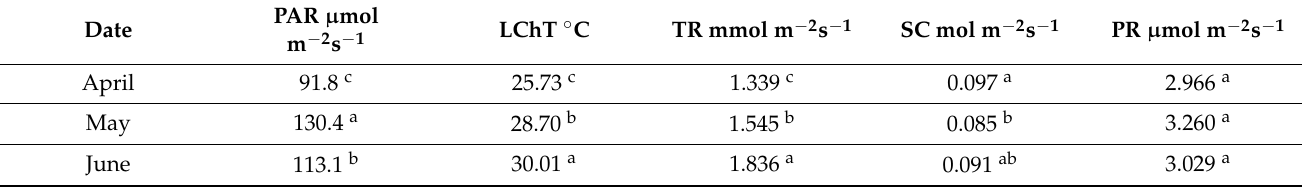
Table 1. Photosynthetically active radiation (PAR, µ mol m − 2 s − 1 ), temperature (LChT, ◦ C), transpira- tion rate (TR, mmol m − 2 s − 1 ), stomatic conductance (SC, mol m − 2 s − 1 ), and photosynthetic rate (PR, µ mol m − 2 s − 1 ) in tuberose established on three planting dates.